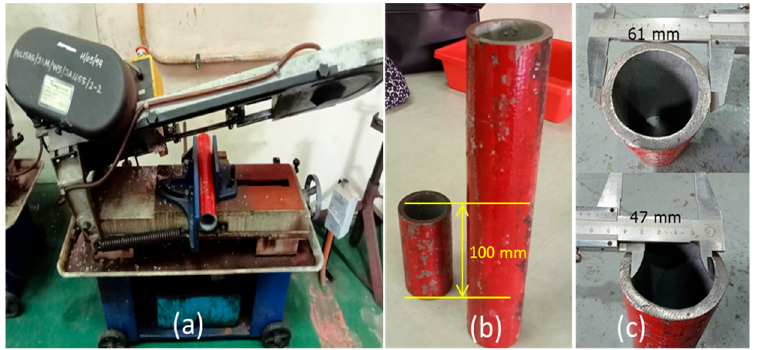
Figure 2. Preliminary process of metal tube confinement fabrication. ( a ) Cutting the metal pipe using bench saw. ( b ) Metal tube with 100 mm length representing TSPC specimen height. ( c ) The initial OD and ID of the metal tube resulting in 7 mm thickness.